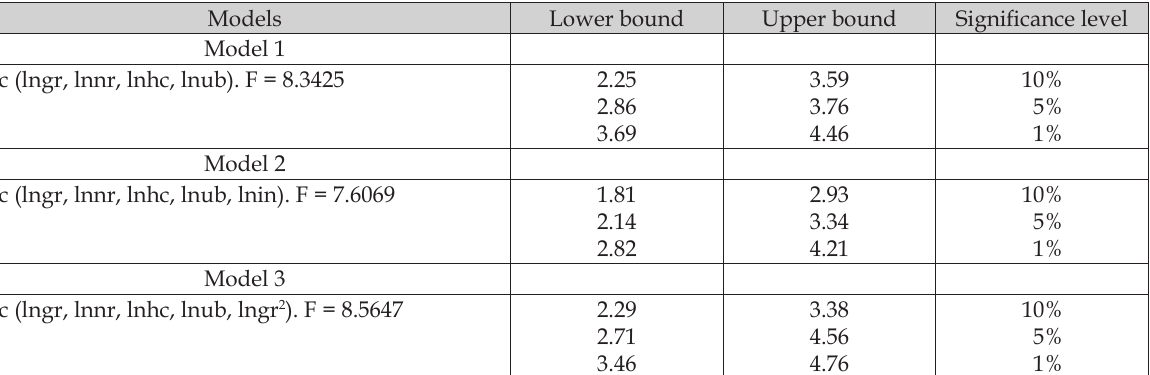
Table 6. Bounds test results.